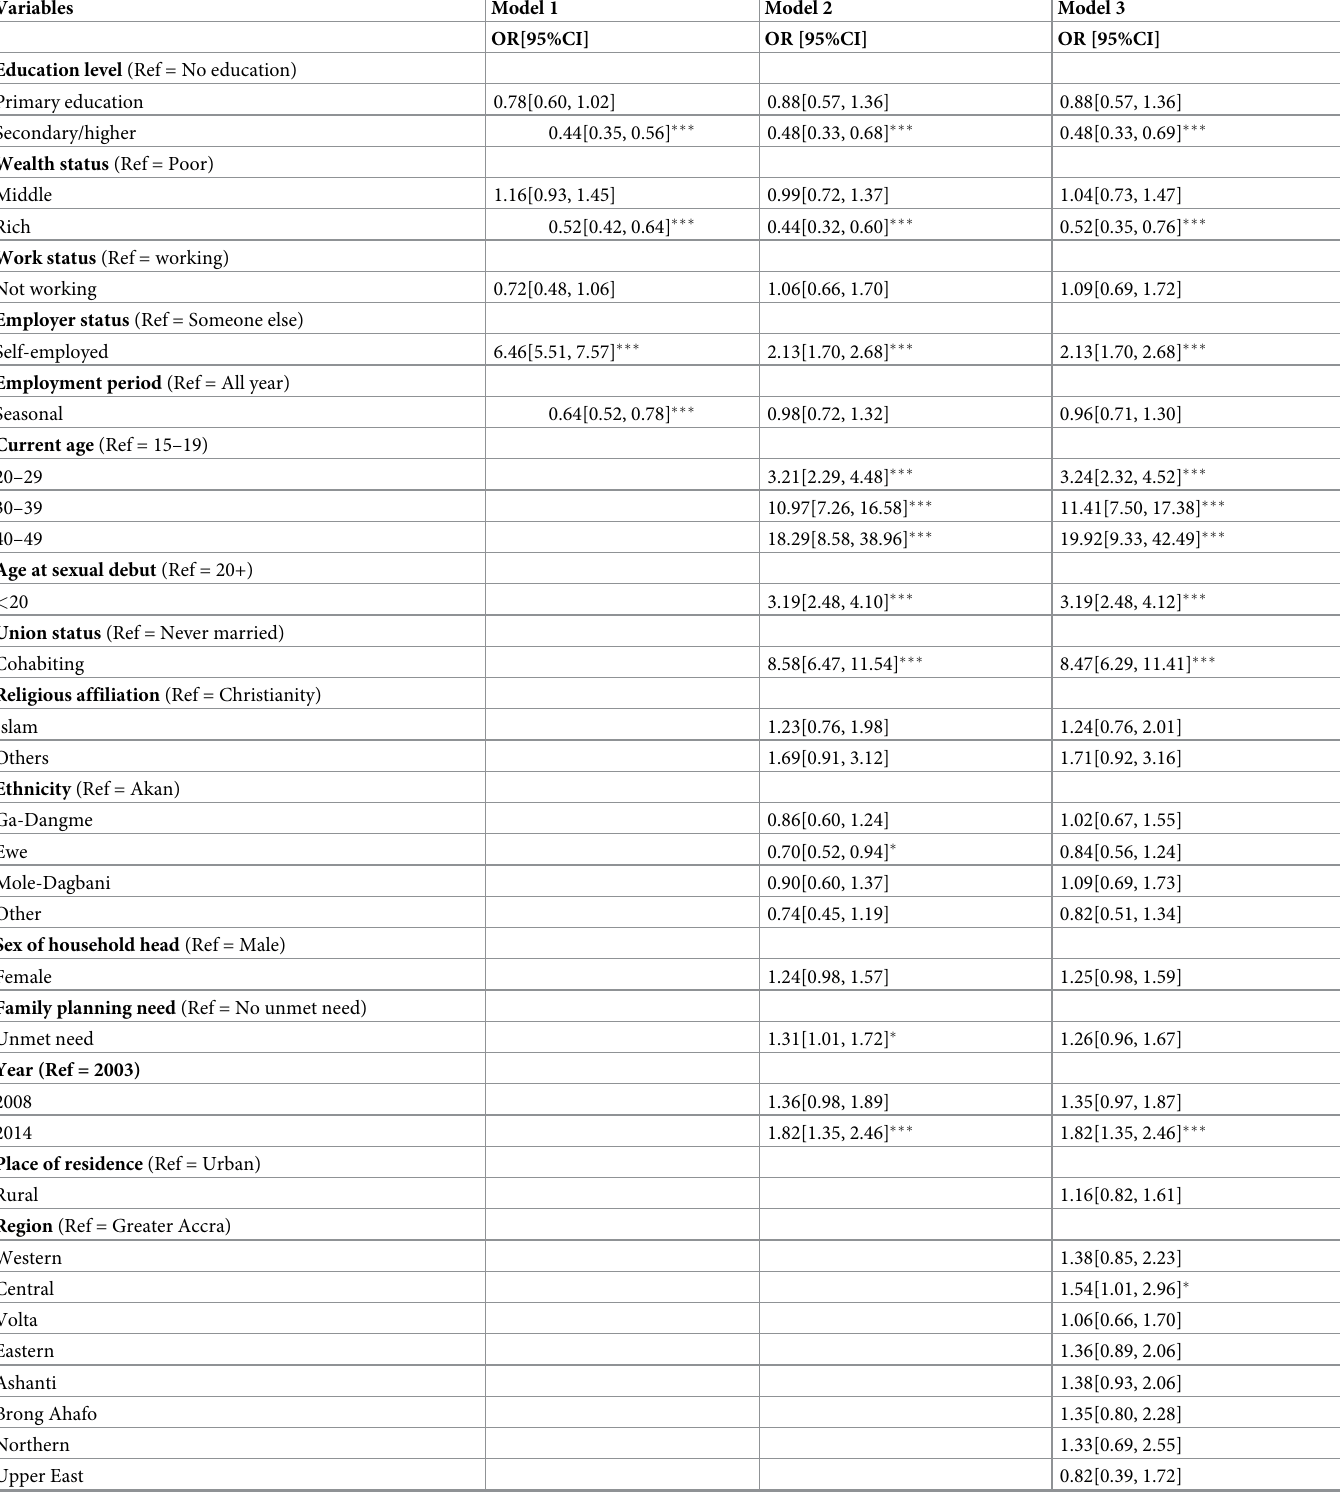
Table 3. Logistic regression analysis of nonmarital fertility levels in